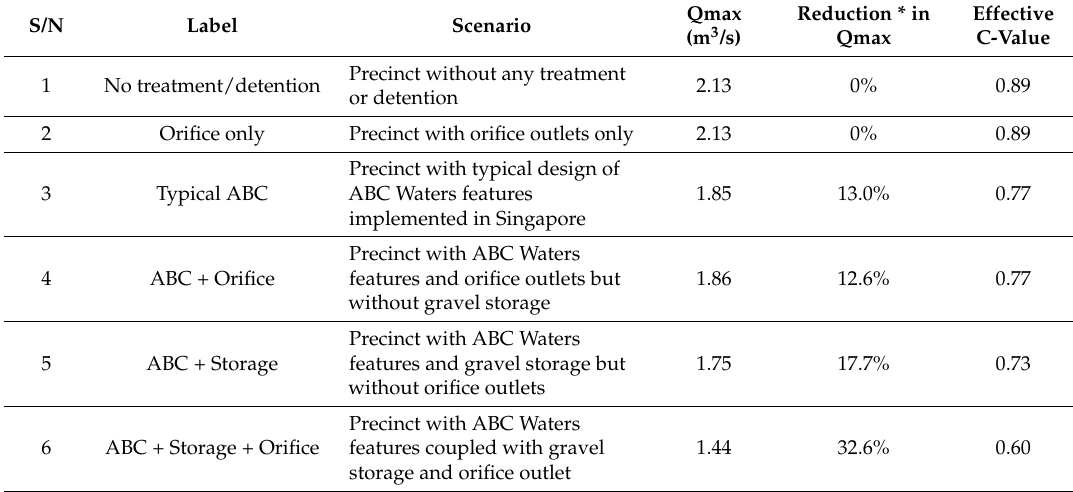
Table 2. Outflow and effective C-value results of the precinct and alternative scenarios for the 10-year design storm.